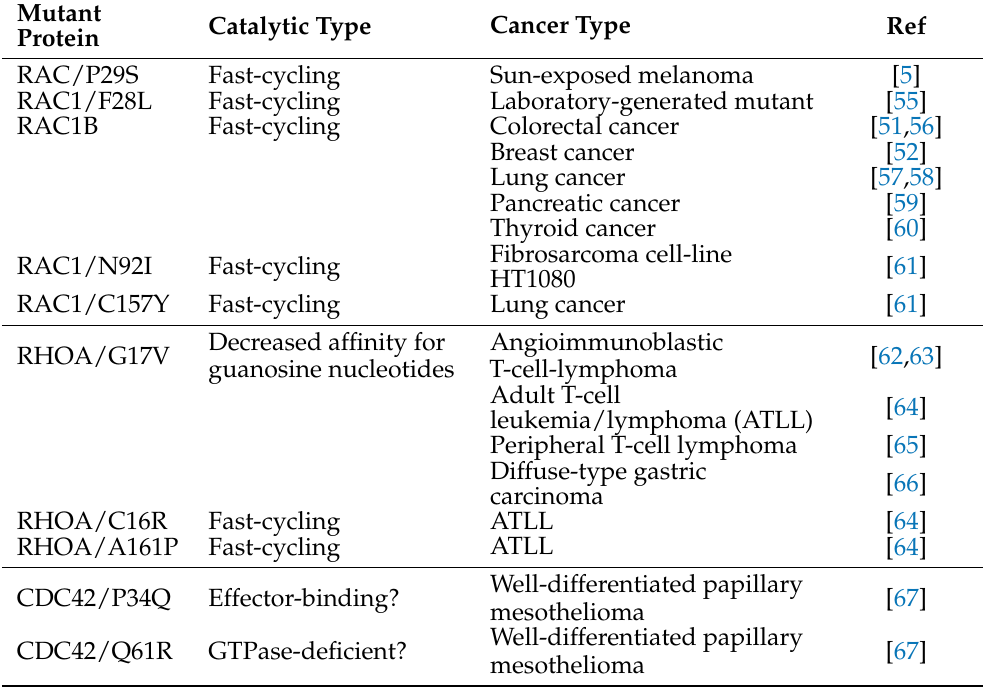
Table 2. Mutant RHO GTPases mentioned in the